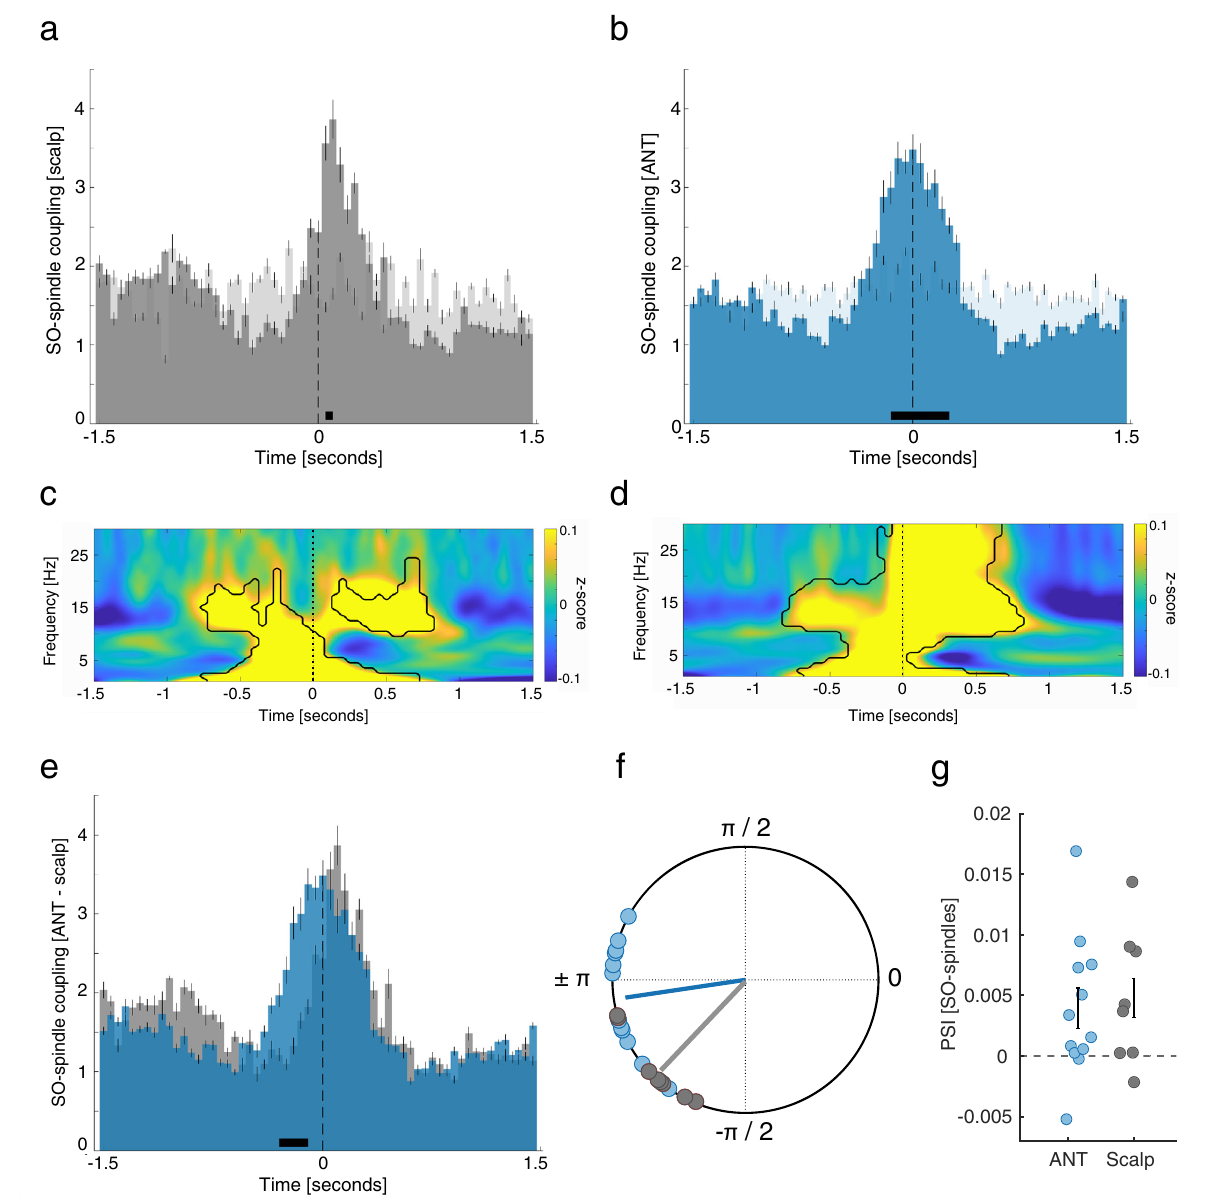
Fig. 6 | ANT spindles lock to early SO phases. a Occurrence probabilities of neocortical spindle onsets with respect to neocortical SO down-states (bin size = 50ms), illustrating that spindles started at the SO down-to-up transition (0.05 – 0.15s; dependent-samples t -test, two-sided, p <0.0001; peak: 0.1 s; cluster correctedacrosstime). b ANTspindlesemergedaroundANTSOdownstates( − 0.15 to 0.25s; dependent-samples t -test, two-sided, p =0.0012; peak: 0 s; cluster cor- rected across time). c Time-frequency representation (TFR) of neocortical SO- spindle events ( N =304.1±69.8;lockedto neocorticalSOdown-states),contrasted against event-free segments. The contour lines indicate clusters (dependent-sam- ples t -test,two-sided, p <0.05,clustercorrectedacrosstimeandfrequency). d TFR of all ANT SO-spindle events ( N =431±52.1, locked to ANT SO down-states), con- trasted against event-free segments. The contour lines indicate clusters (depen- dent-samples t -test, two-sided, p <0.05, cluster corrected across time and frequency). e Comparing the occurrence probabilities of ANT (blue) and neocor- tical SO-spindle complexes (gray) yielded that ANT spindles locked signi fi cantly